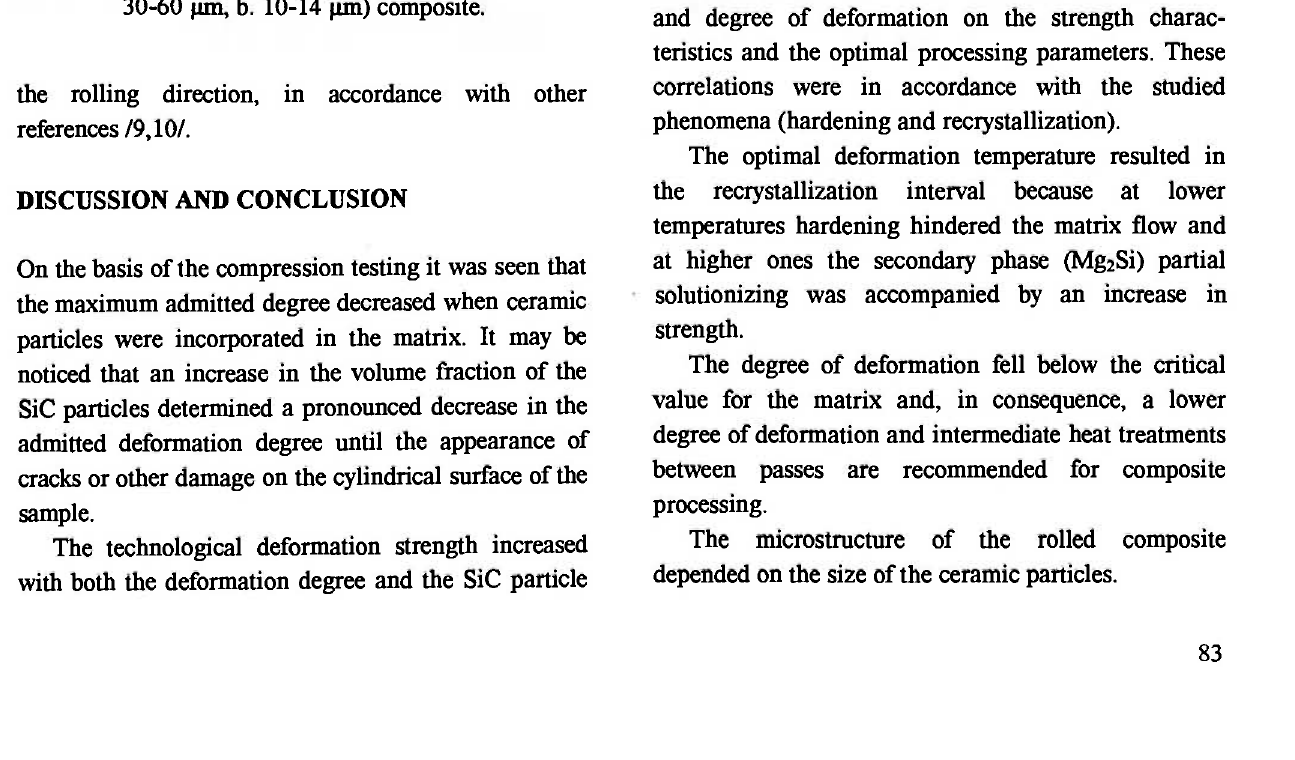
Fig. 6: Micrography of hot rolled 6063/SiCp (size a. 30-60 μιη, b. 10-14 μιη)